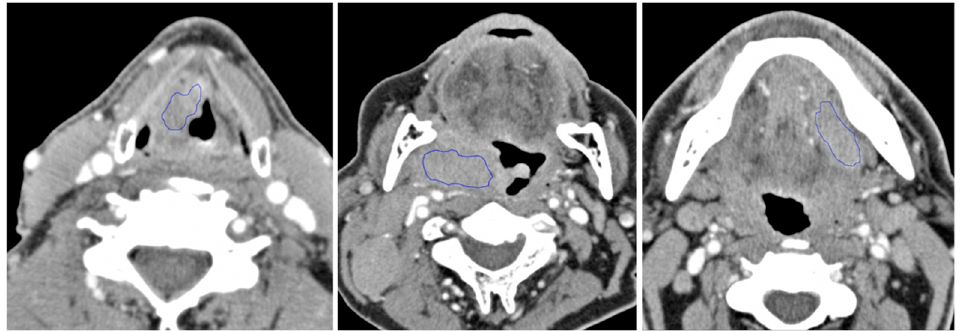
Figure 1. Examples of tumor segmentation using manually placed ROI contours in three different primary tumor locations: larynx/hypopharynx (left), oropharynx (middle), and oral cavity